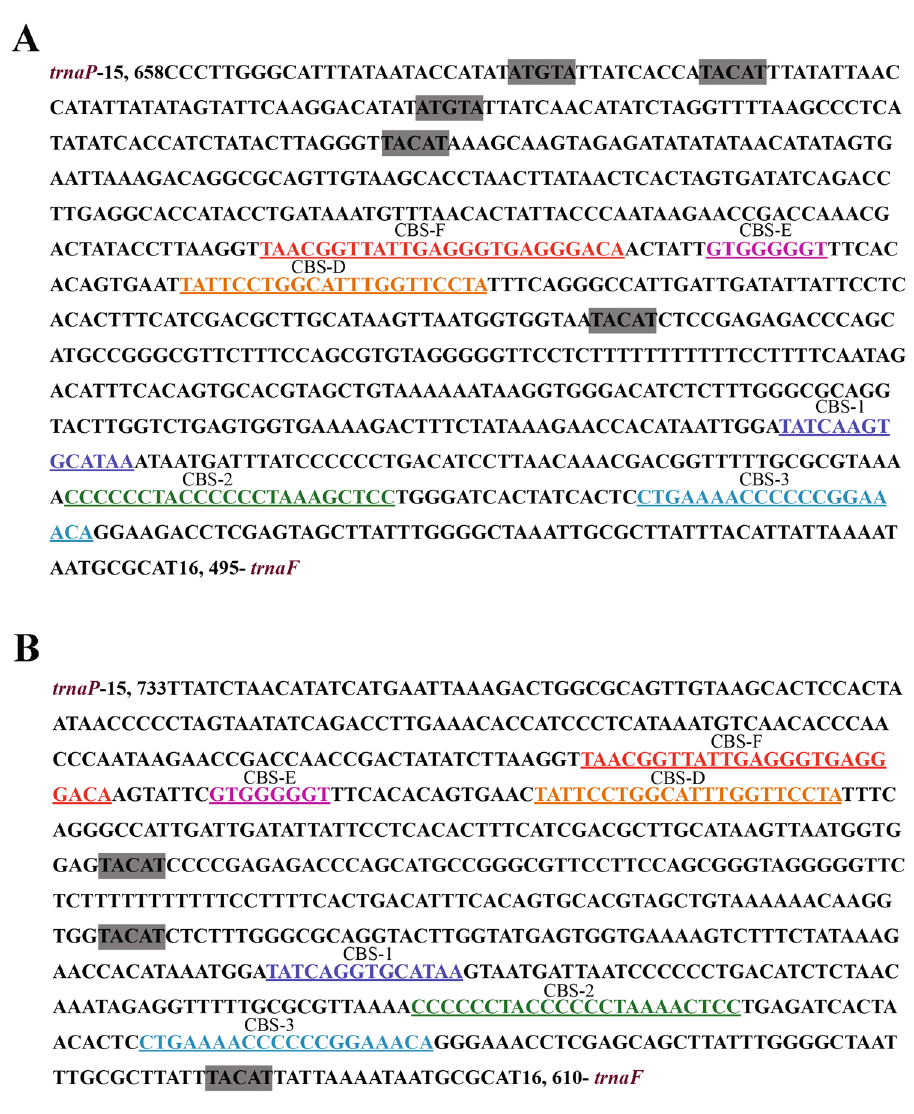
8 Scientific RepoRts | 7: 1553 | DOI:10.1038/s41598-017-01654-y